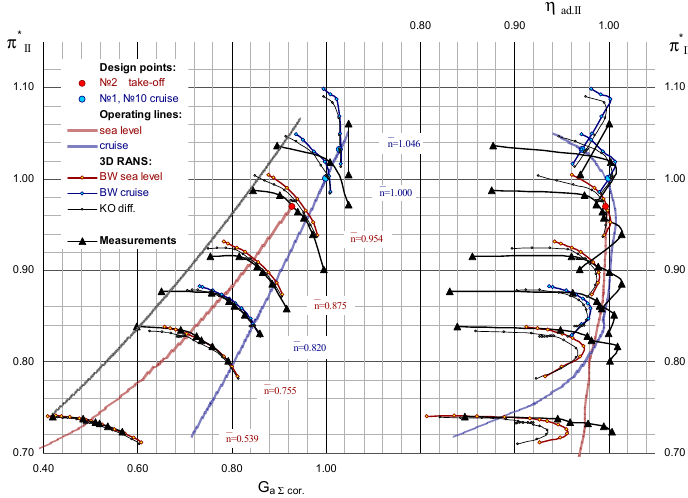
Figure 23. Test results for the C180-2 stage bypass duct. BW: 3D computation with Baldwin–Lomax algebraic turbulence model; KO diff: 3D computation with k- ω differential turbulence model.